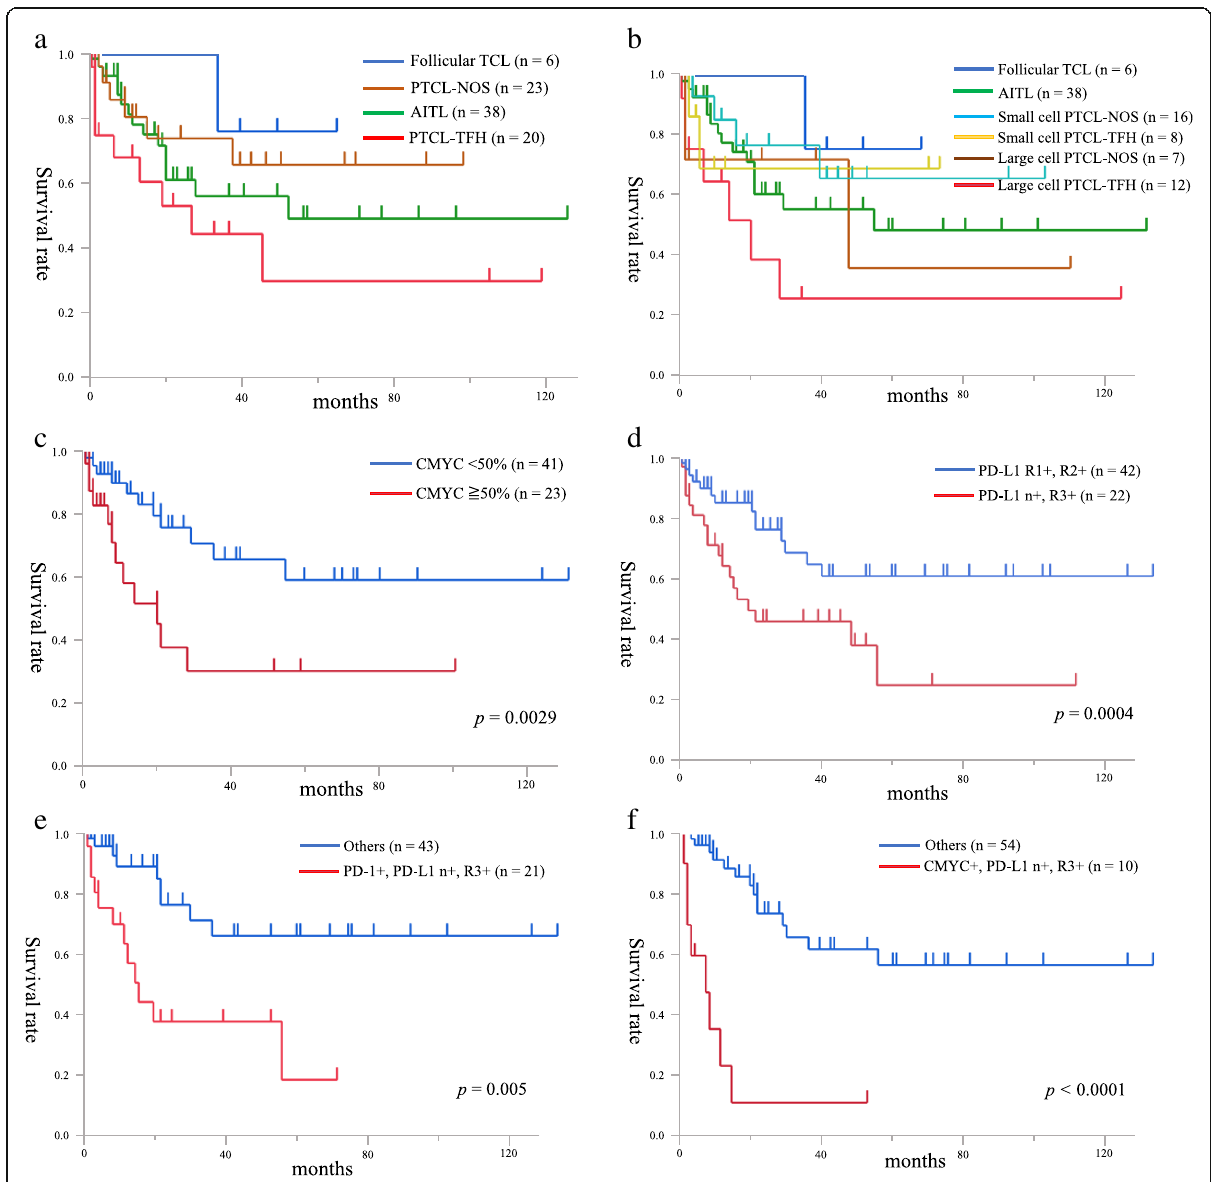
Fig. 4 a No significant differences in overall survival (OS) were detected among 20 PTCL-TFH patients, 23 PTCL-NOS, and 38 AITL. b 12 large cell PTCL- TFH patients show significantly worse OS than small cell PTCL-TFH ( n =8; p= 0.045), AITL ( n =38; p= 0.047) and F-TCL ( n =6; p= 0.012). c CMYC+ tumour cells ( n =23) are a poor prognostic factor in 64 patients with TFH+ PTCLs ( p= 0.029). d 22 patients with both PD-L1+ tumour cells and R3+ PD-L1+ cells show significantly worse OS than 42 with R1+ and R2+ PD-L1+ cells ( p= 0.0004). e 21 patients with both PD-1+ tumour cells and high PD-L1+ group ( n +and R3+) show significantly worse prognosis than 43 of the other group ( p= 0.005). f 10 patients with both CMYC+ tumour cells and high PD-L1+ group show significantly poorer OS compared with 54 patients in the other groups of TFH+ PTCLs ( p<